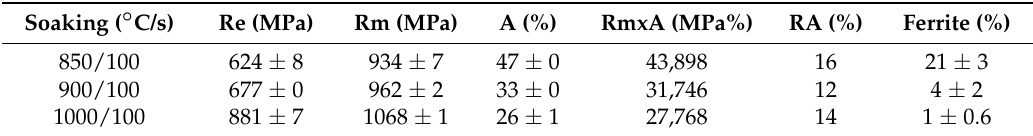
Table 2. Effect of soaking temperatures on tensile strength, total elongation, formability factor (strength and total elongation product), retained austenite volume fraction, and fraction of polygonal